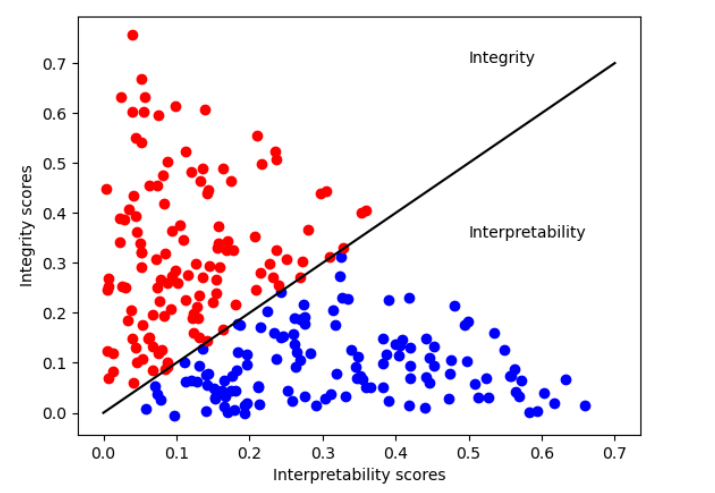
Figure 12. Decision distribution classified into two groups: interpretability and integrity. The points cannot have a high value on both axes because interpretability importance parameters are the inverse of the integrity importance parameters ( alpha and 1 − alpha